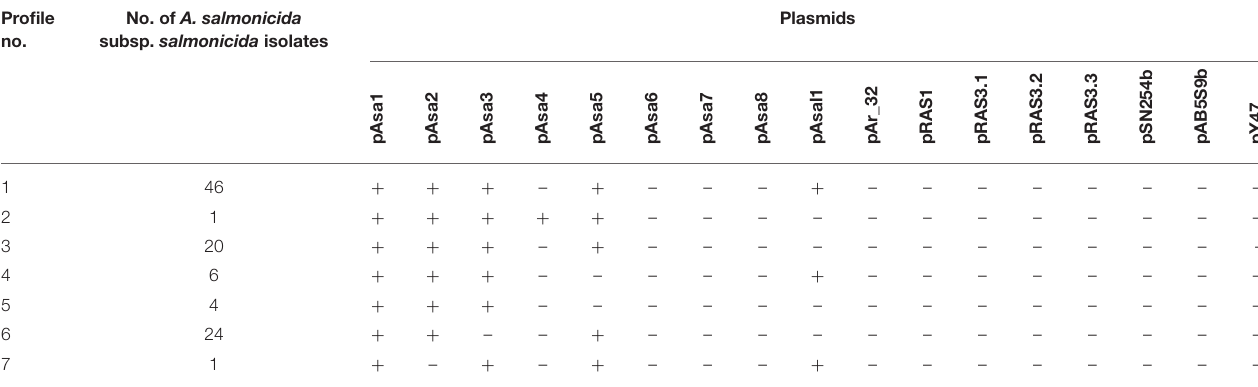
TABLE 2 | Overview of plasmid profiles among the 101 A. salmonicida subsp. salmonicida sequenced isolates and the reference A449. Profile